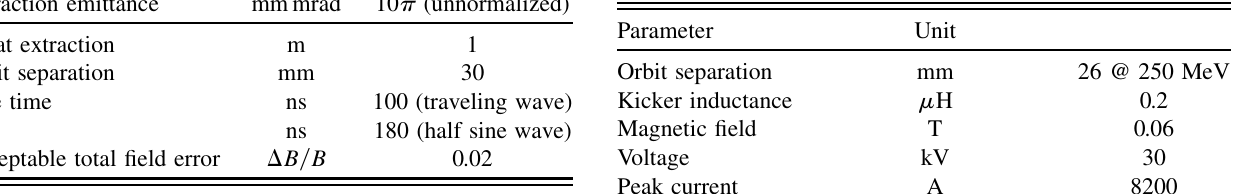
TABLE XX. Kicker specifications in PAMELA for vertical extraction (full